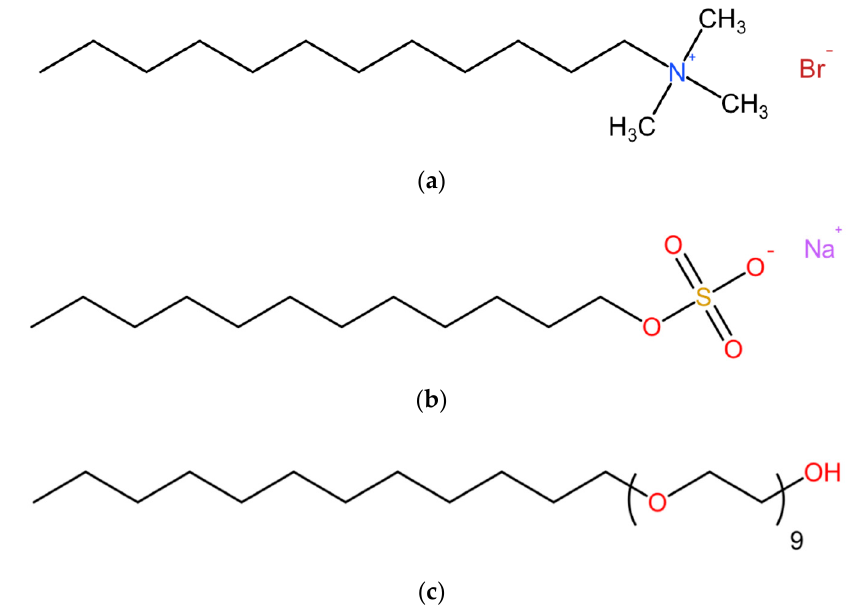
Figure 2. Schematic diagram of the molecular structure of the surfactants used in this work. ( a ) Dodecyltrimethyl-ammonium bromide (DTAB). ( b ) Sodium dodecyl sulfate (SDS). ( c ) Fatty alcohol polyoxyethylene ether-9 (AEO-9).